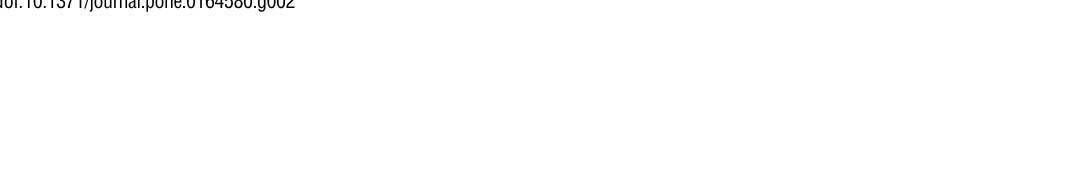
Fig 2. Sampling localities of phlebotomine sand flies in rural locations in the state of Espı´rito Santo, southeastern Brazil, during the period between 1997 and 2013. Datum: SIRGAS 2000.